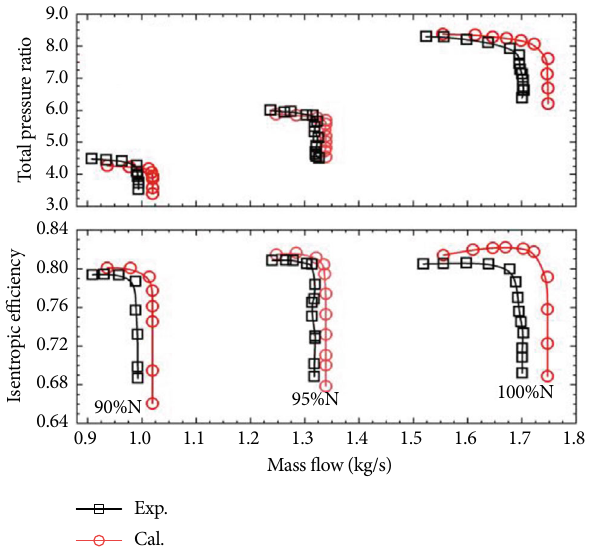
Figure 5: Pressure ratio 8:1 compressor performance at di ff erent rotating